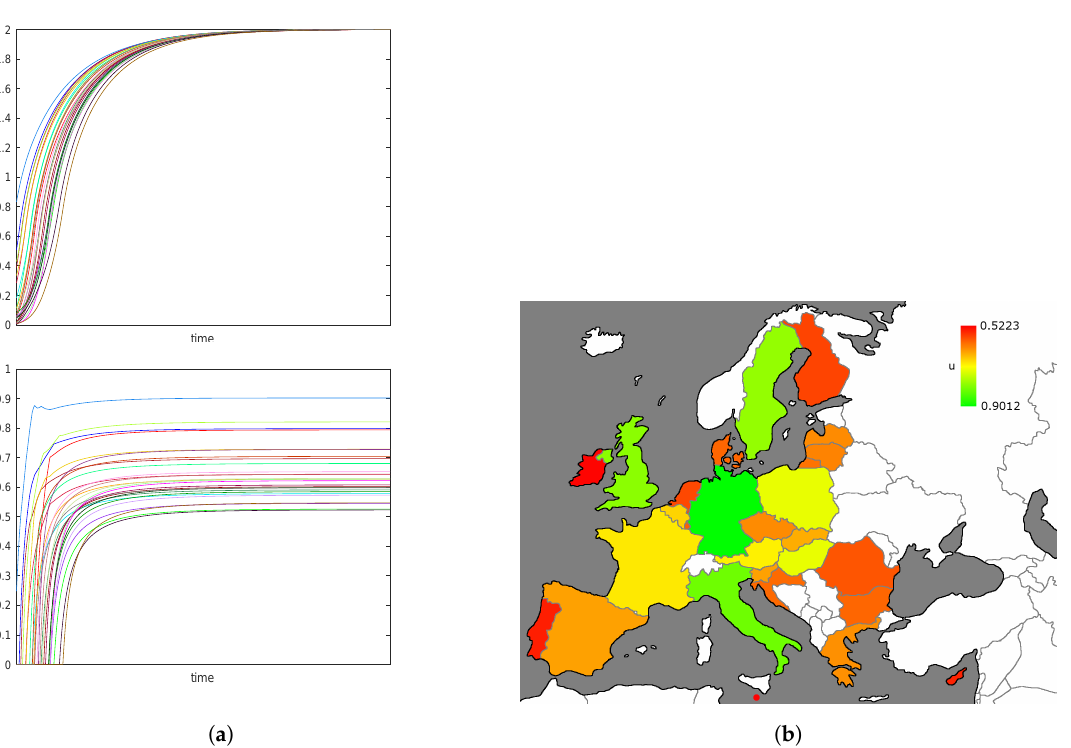
Figure 2. Pollution stock x and investment u into environmentally friendly policies for each player. ( a ) Pollution stock x and investment u into environmentally friendly policies for each player without any external control on pollution costs ( β = 1); ( b ) Overview of the Investments into Green Policies. Red color denotes a low investment into green policies, green color a large